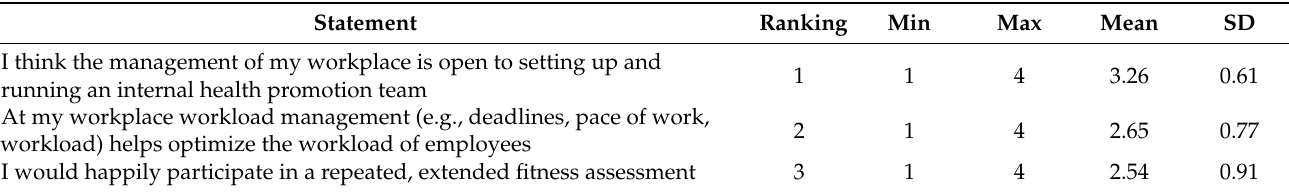
Table 6. Workplace health promotion (N = 46).